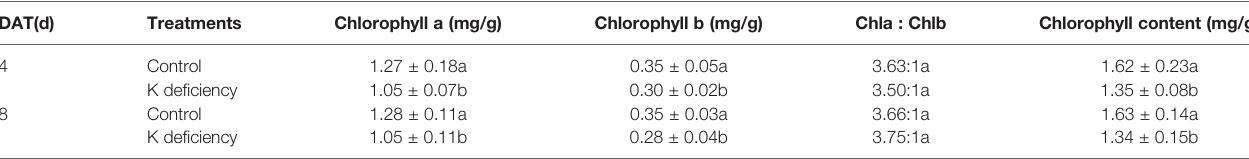
TABLE 4 | Effect of K + de fi ciency on chlorophyll at 4/8 days after transfer day (DAT)*.